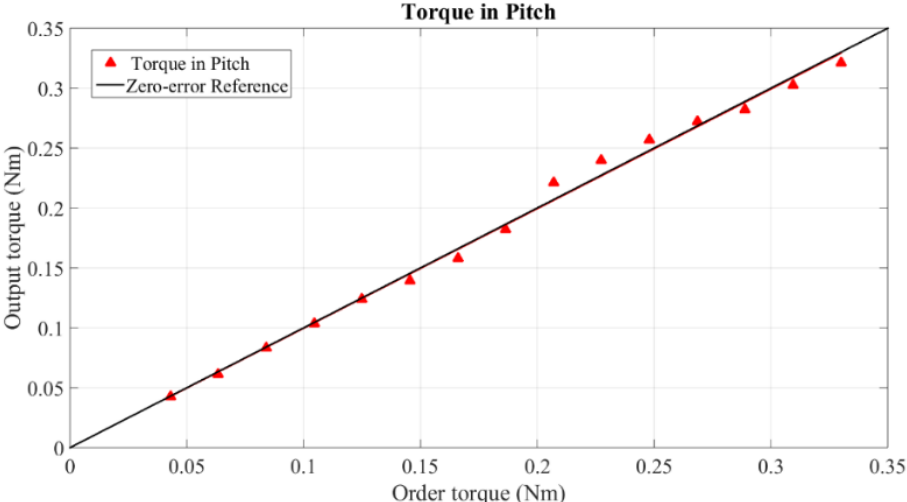
Figure 19. Forces at three points along Y-axis. Figure 20. Forces at three points along Z-axis. Since the digital force gauge is unable to measure torques, torque calibration is based on force measurement with the given arm of 165 mm. Representative experimental results (torque in pitch and force of middle finger) are shown in Figures 21 and 22. The measurable peak torque is 0.6 Nm. This value is larger than 0.15 Nm of Delta 6 and 0.4 Nm of Sigma 7, but less than 1.72 Nm of HD 2 High Definition. From the data of Figure 21, the average error of torque is 0.00049 Nm with a